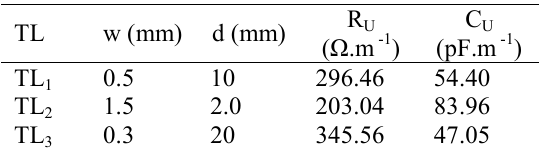
Table 3: Parameters of the interconnect microstrip line under consideration.